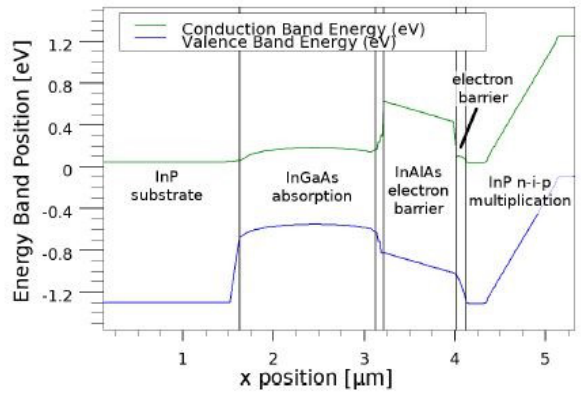
Figure 3: A self-quenched SPAD using a InAlAs-InP conduction band offset to trap electrons and create a negative sheet charge. This design allows the multiplication region to have close proximity to the surface